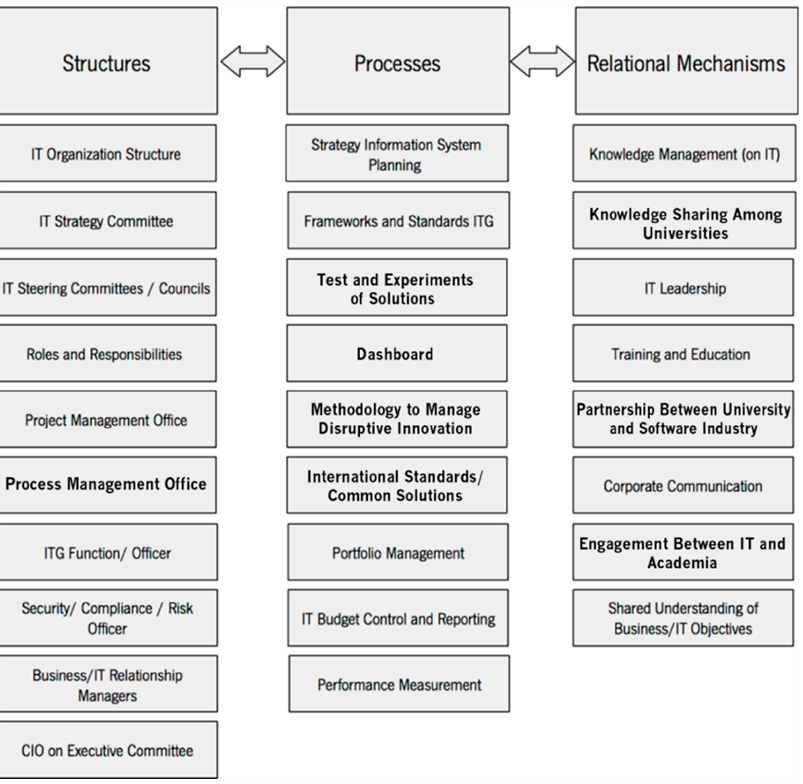
Figure 2. ITG Practices Baseline.